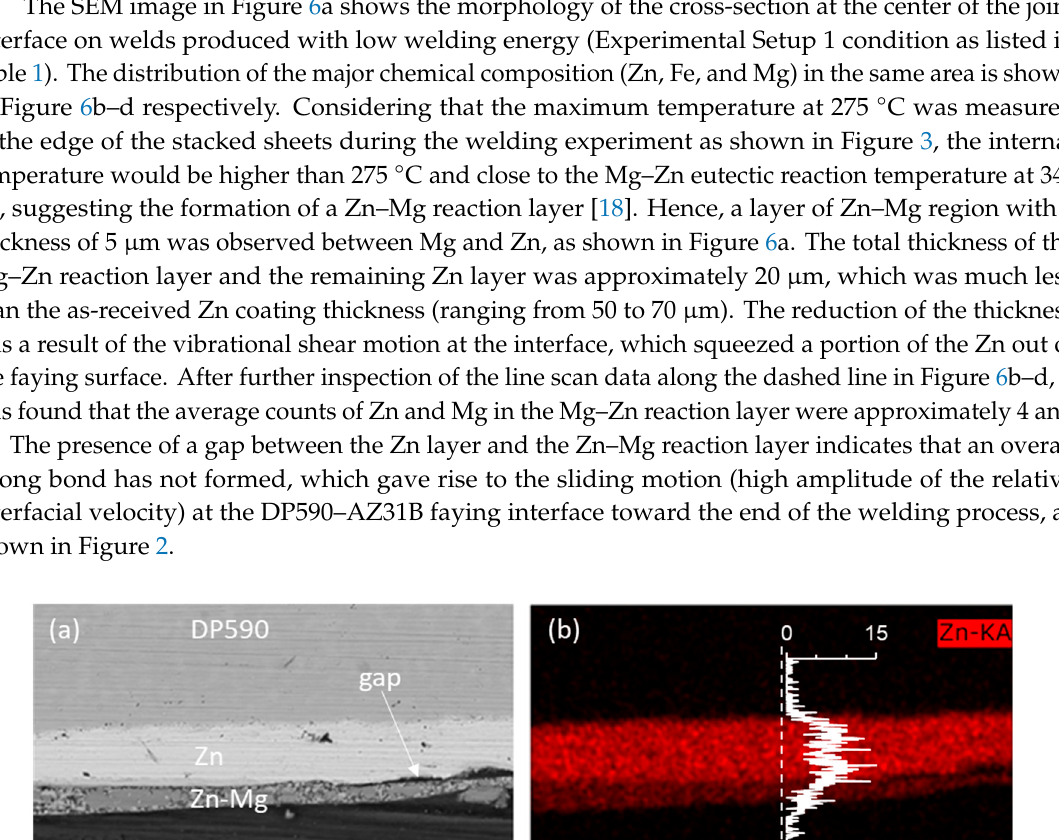
Figure 5. Relation between maximum tensile load and the number of fatigue cycles to failure measured on the weld coupons that were produced in Experimental Setup 2 condition as listed in Table 1. The inserted image shows two fracture modes: interfacial fracture and parent AZ31B fracture.